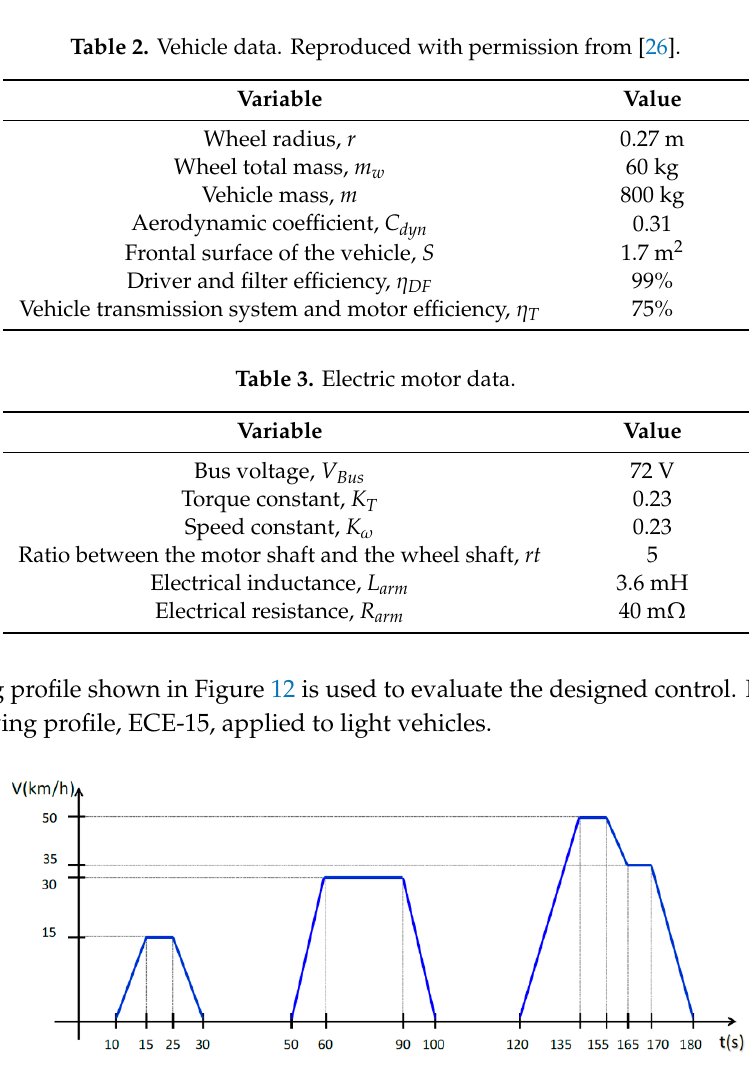
Figure 11. Block diagram with a simplified inner loop.